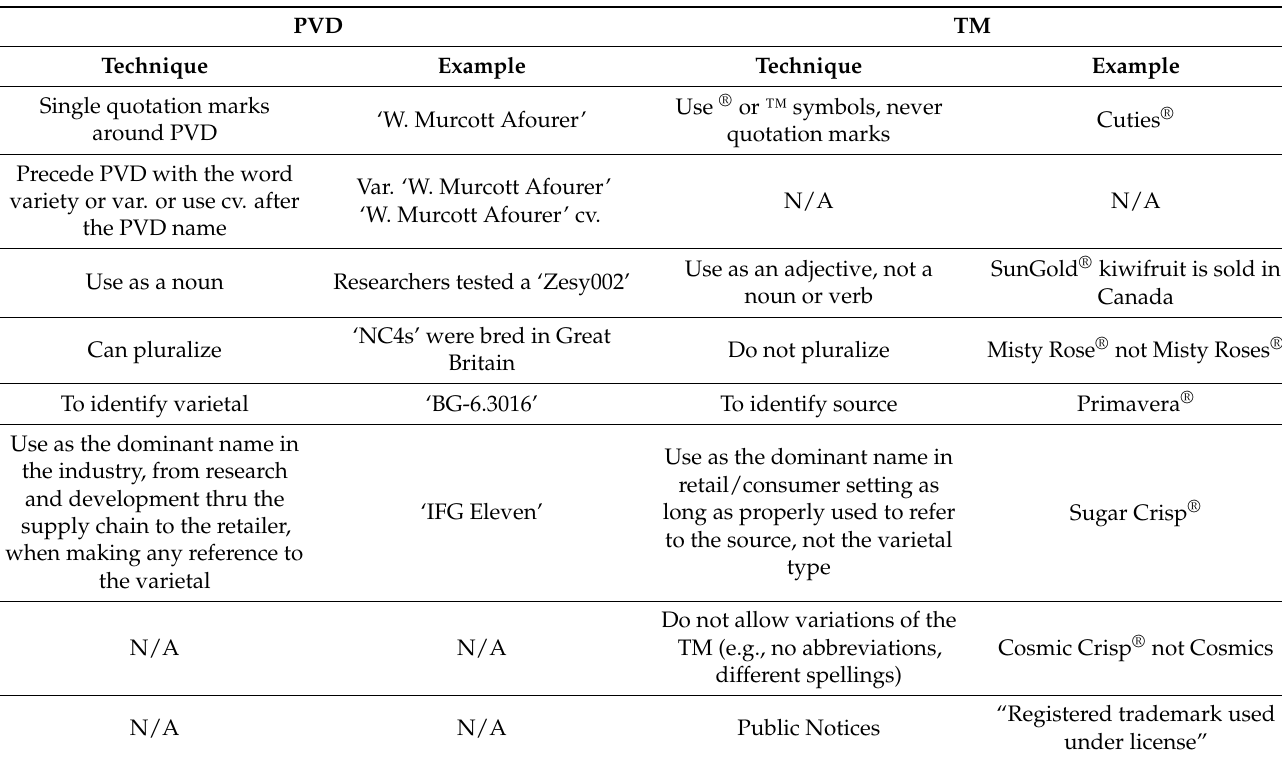
Sources: Table design and most examples are authors’ work; techniques: